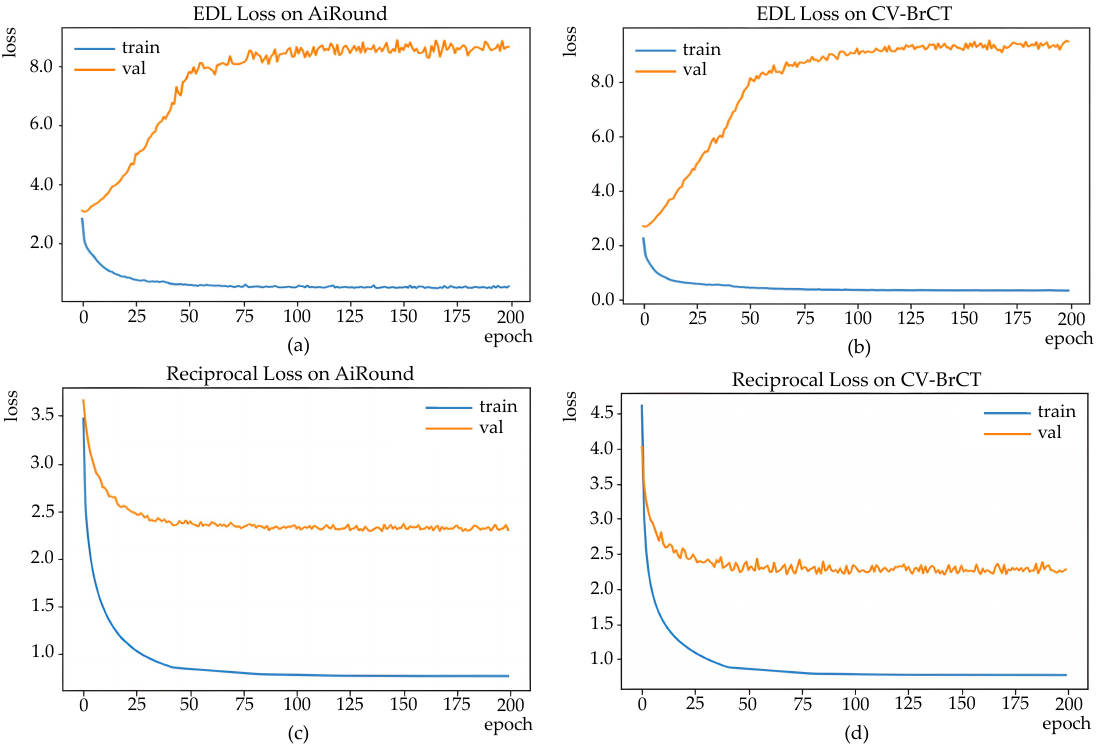
Figure 13. The training and validation loss using ( a ) EDL Loss on AiRound and ( b ) on CV-BrCT, and using ( c ) Reciprocal Loss on AiRound and ( d ) on